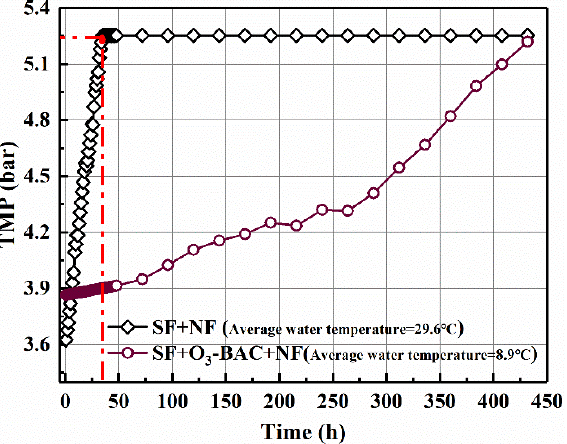
Figure 2. TMP as a function of filtration time of water pre-treated by SF and SF+O 3 -BAC. Therefore, some specific organic fractions in the feed water are a good indicator to predict membrane biofouling and TMP increasing. In order to better explain the mitigation mechanism of the two pre-treatment processes on NF membrane fouling, HPSEC and EEM analyses were used to further analyze different water